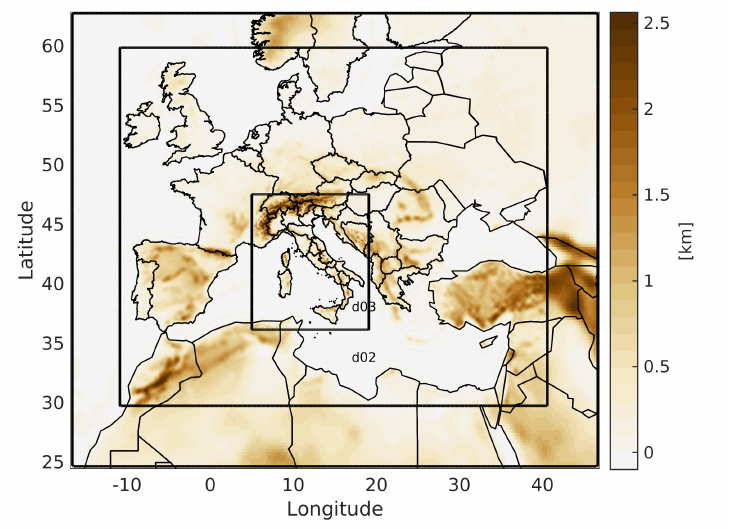
Figure 1. The three nested domains adopted for the WRF